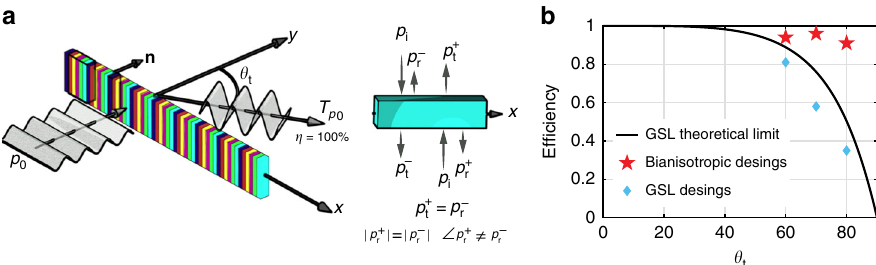
Fig. 1 Desired metasurface and achieved performance. a Illustration of the desired performance of a perfect anomalous refractive metasurface. η denotes the energy ef fi ciency. All the energy is pointing out toward the desired direction with no parasitic scattering. The inset shows the bianisotropic response of the elements of the metasurface, that is, the asymmetric response for incident waves from opposite directions (the phase of the re fl ected wave are different). b Comparison of the ef fi ciency for anomalous transmission metasurfaces. Bianisotropic designs show great advancement especially for large de fl ection angles. Realized ef fi ciencys are slightly lower than the theoretical limit as a result of discretization